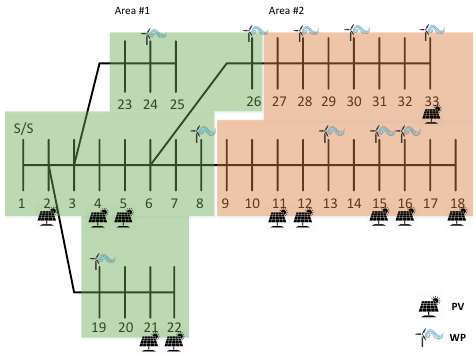
Figure 30. Snapshot—mean value—Scenario #3